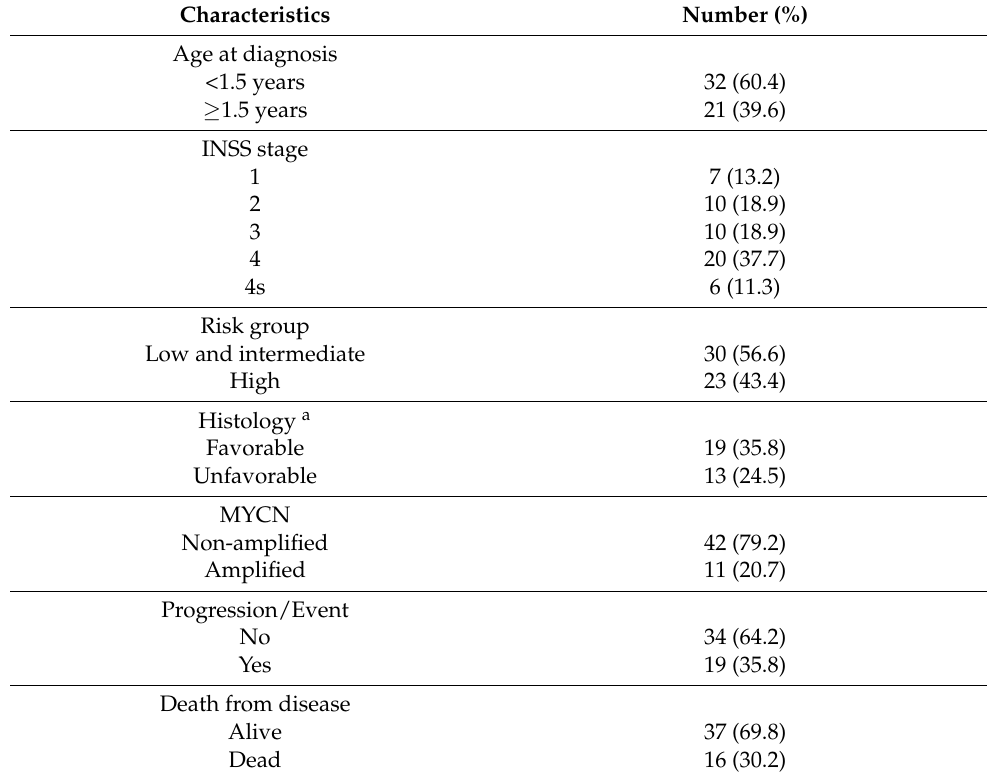
Table 1. Clinical and pathological characteristics of 53 neuroblastoma (NBL)